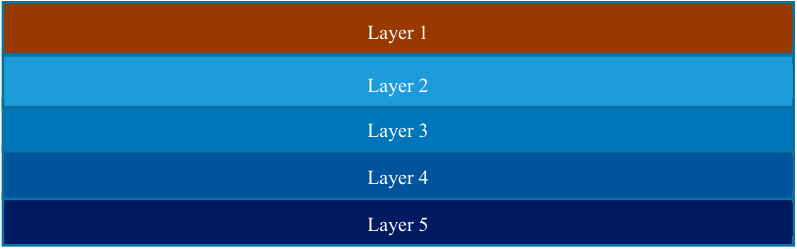
Figure 6. Discretized straight beam-like sample.